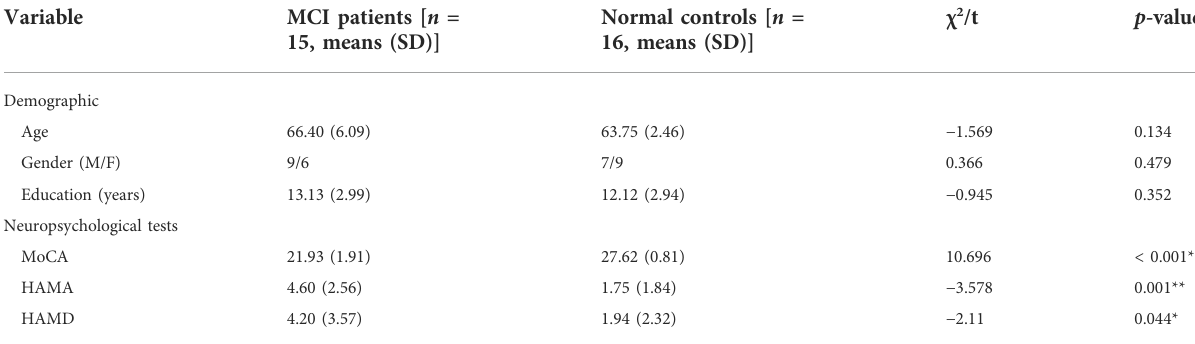
TABLE 1 Demographic and neuropsychological test results of MCI patients and normal controls.